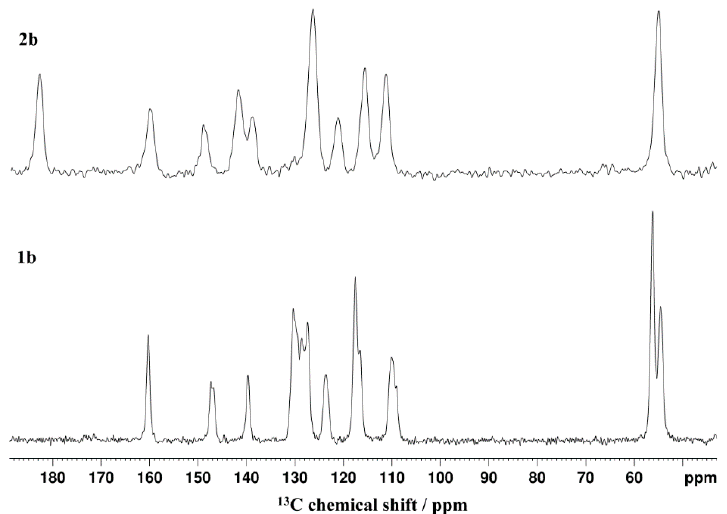
Figure 3. 13 C CP-MAS NMR spectra of compounds 1b and 2b . For signal assignments see Tables 2 and 3.